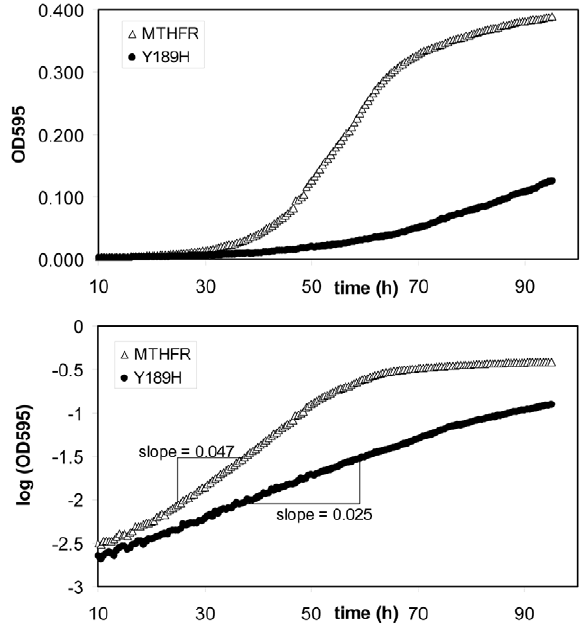
Figure 1. Example growth curves from which rate metrics were calculated. Shown are two examples (major MTHFR allele (open triangle); Y189H substitution variant (closed circle)) where growth in liquid culture was tracked over time, according to Methods. The upper panel shows absorbance (OD 595 ) values and the lower panel shows the